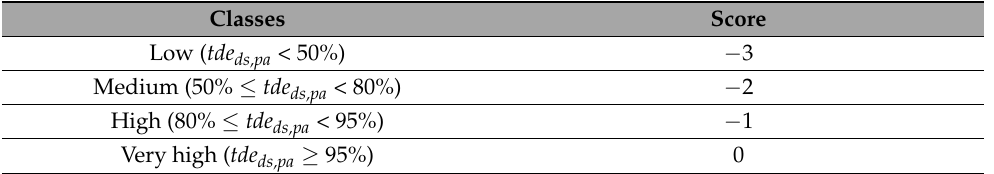
Table 14. TDe ds,pa —temporal